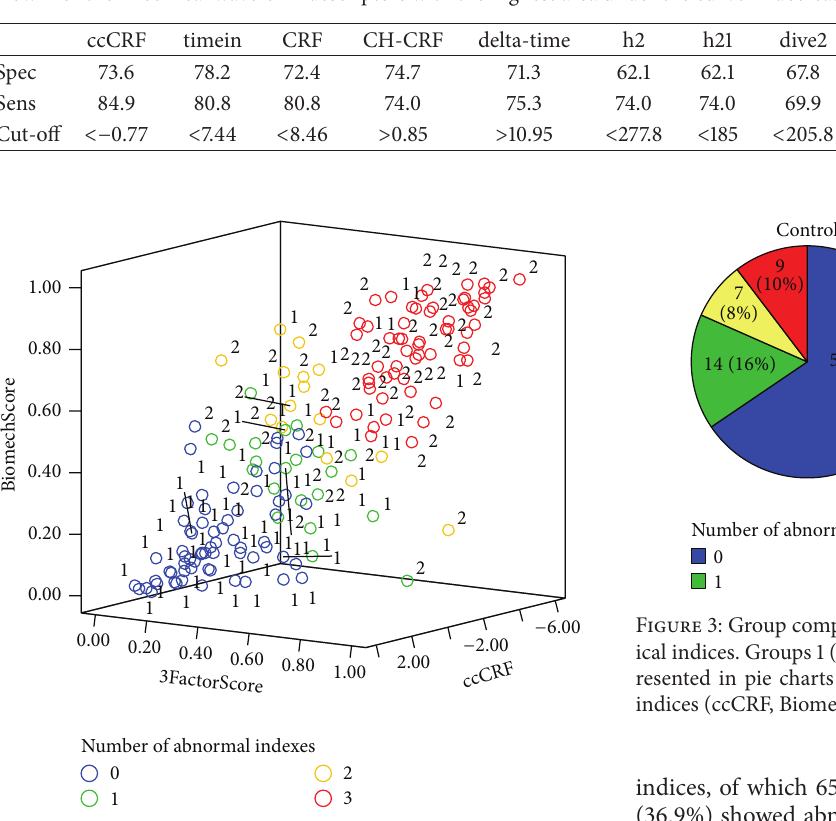
Figure 2: Distribution of the three best biomechanical indices for both groups combined. Three-dimensional plot of ccCRF, Biomech- Score, and 3FactorScore in which the color of each observation indicates the number of abnormal indices (from 0 to 3). The number next to each observation indicates the group to which it belongs (group 1 or 2).